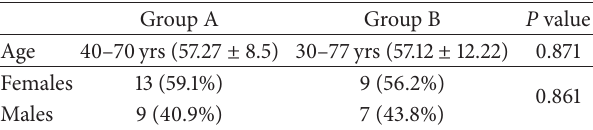
Table 1: Demographic data of